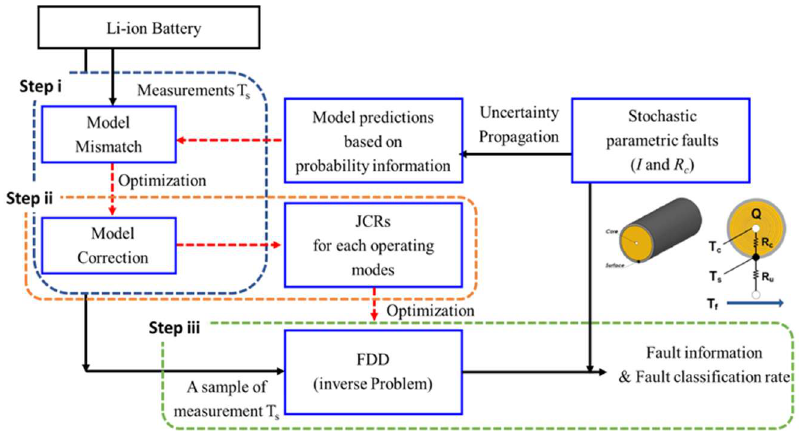
Figure 6. Overview of the proposed FDD algorithm.